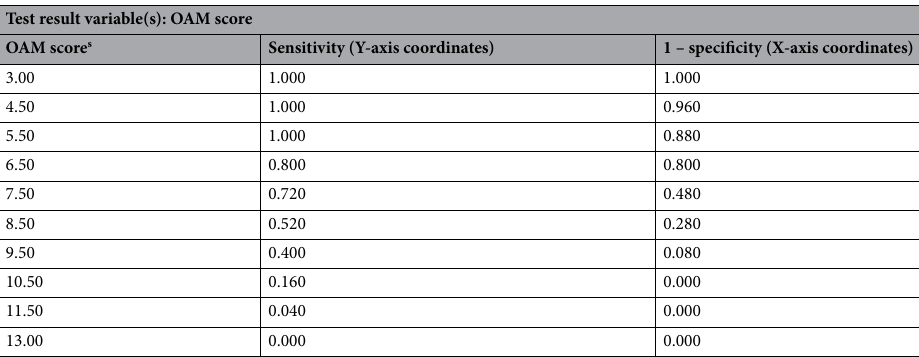
Table 1. Sensitivity and 1-specificity values at different allele matching scores (AMS), calculated based on the ROC curve (Coordinates of the curve) in B-S kinship analysis by Autosomal STR. The smallest OAM cutoff score value is the minimum observed test value minus 1, and the most considerable cutoff value is the maximum perceived test value plus 1. All the other cutoff values are the averages of two consecutive ordered observed test